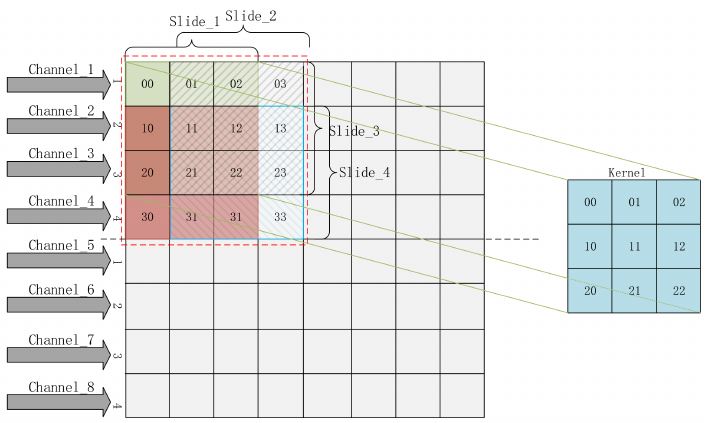
Figure 4. The 4 × 4 convolution window (the red dotted box) contains four 3 × 3 sub-windows: Slide_1, Slide_2, Slide_3, and Slide_4, which are marked with different colors or streaks, respectively.